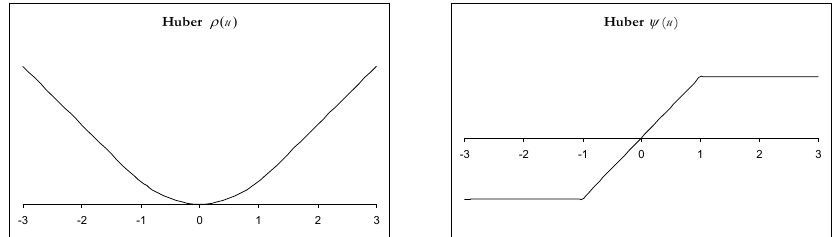
Figure 3 – Huber’s function for k =1 (left panel) and the corresponding derivative (right panel).